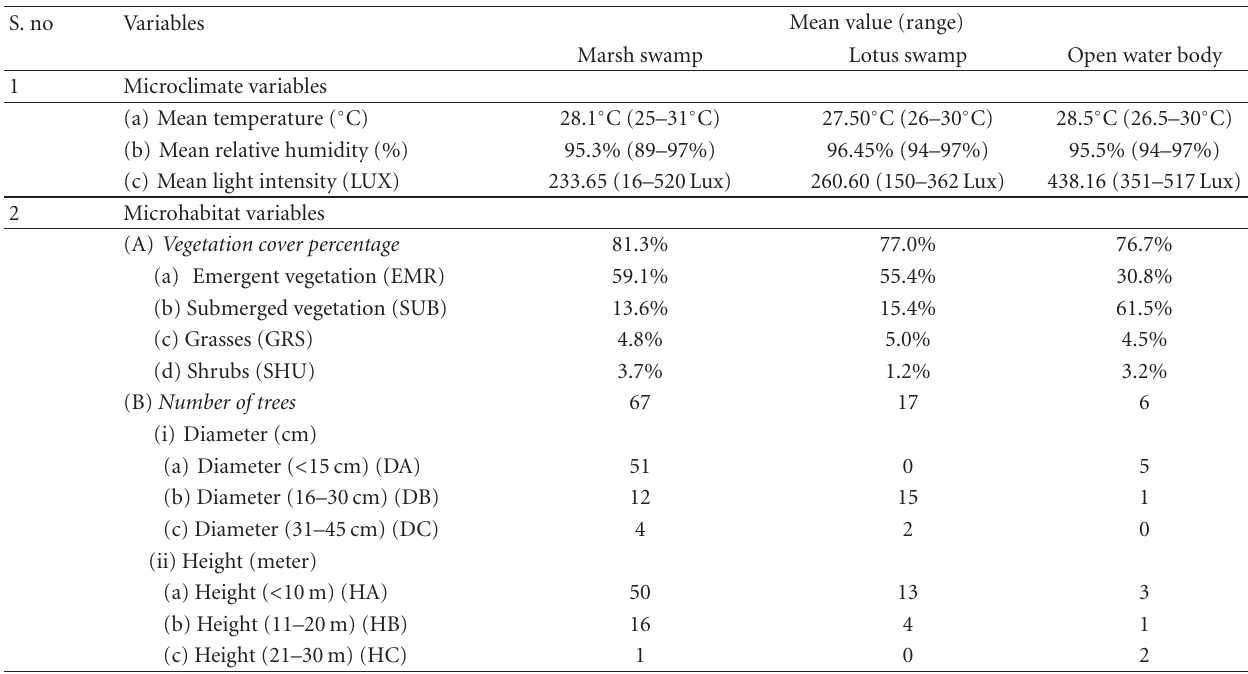
Table 2: List of microclimate and microhabitat variables of marsh swamp, lotus swamp, and open water body at the Paya Indah Wetland Reserve, Peninsular